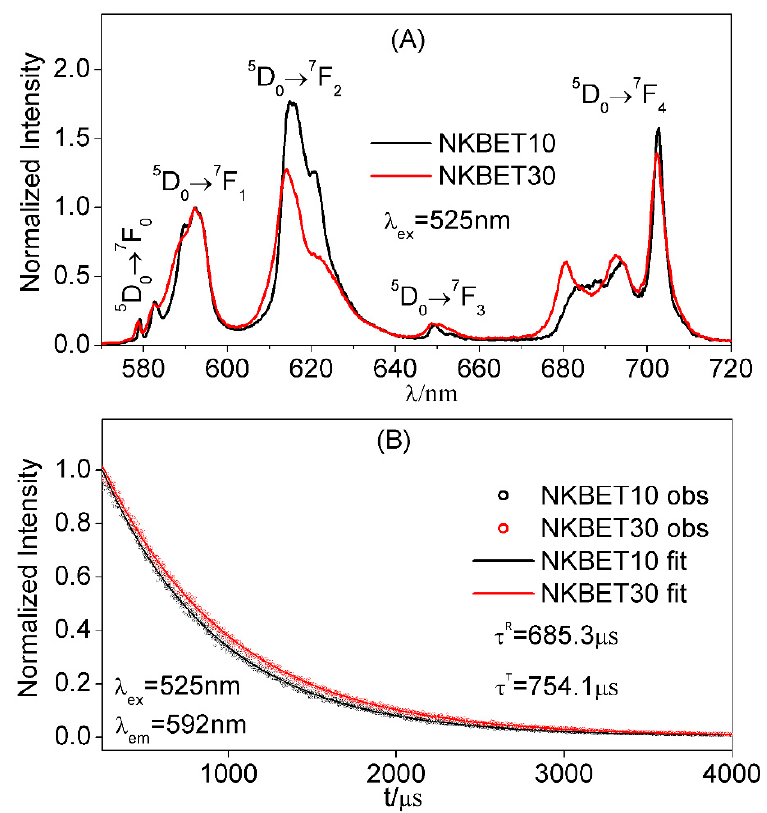
Figure 2. ( A ) The luminescence spectra of (Na 0.9 ,K 0.1 ) 0.5 Bi 0.497 Eu 0.003 TiO 3 (NKBET10) and (Na 0.7 ,K 0.3 ) 0.5 Bi 0.497 Eu 0.003 TiO 3 (NKBET30) ceramics. ( B ) The luminescence decay curves of NKBET10 and NKBET30 ceramics, fitted with a monoexponential function I ( t ) = I ( 0 ) exp ( − t / τ )